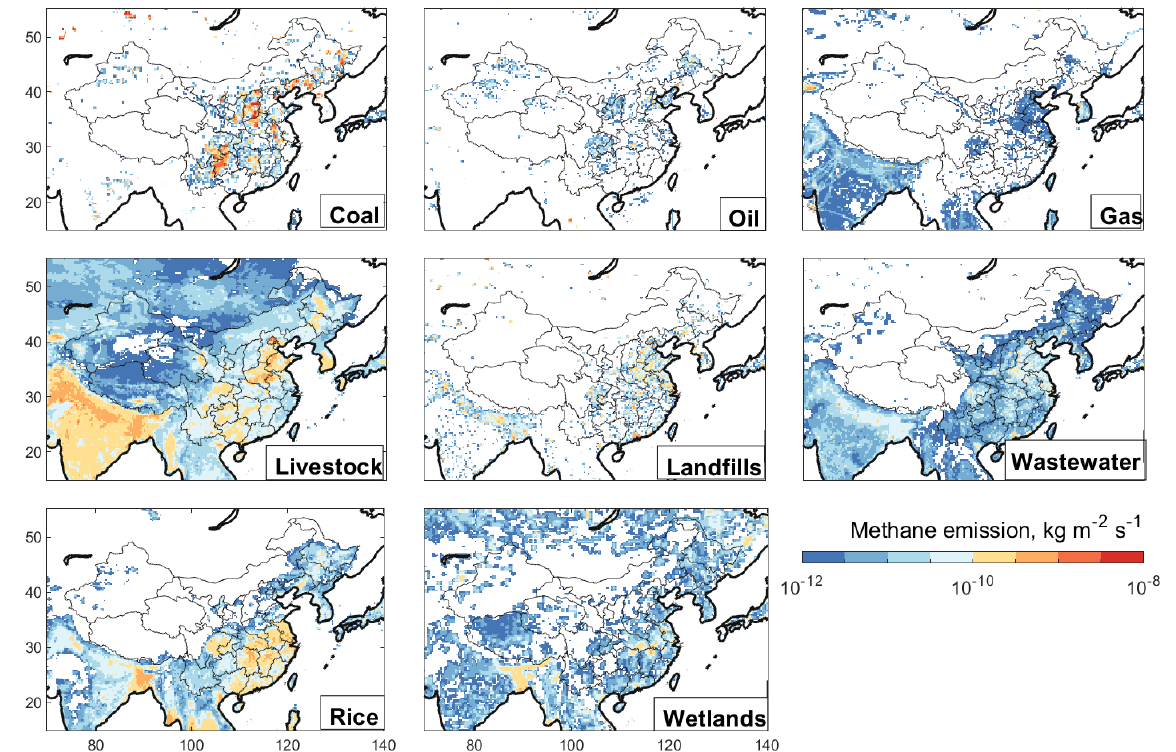
Figure 3. Prior estimates of methane emissions used for the inversion. Coal, oil, and gas emissions are from the GFEIv2 gridded version of the national inventories from individual countries reported to the UNFCCC (Scarpelli et al., 2022). Other anthropogenic emissions for China are from its UNFCCC report with spatial allocation from EDGAR v4.3.2, while for other countries they are from EDGAR v4.3.2. Wetland emissions are 2019 monthly means of the nine-member high-performance subset of the WetCHARTs inventory ensemble (Ma et al., 2021) and are shown here as the annual means for 2019. White areas have emissions lower than 1 × 10 − 12 kgm − 2 s − 1 . Total emissions for China are listed in Table